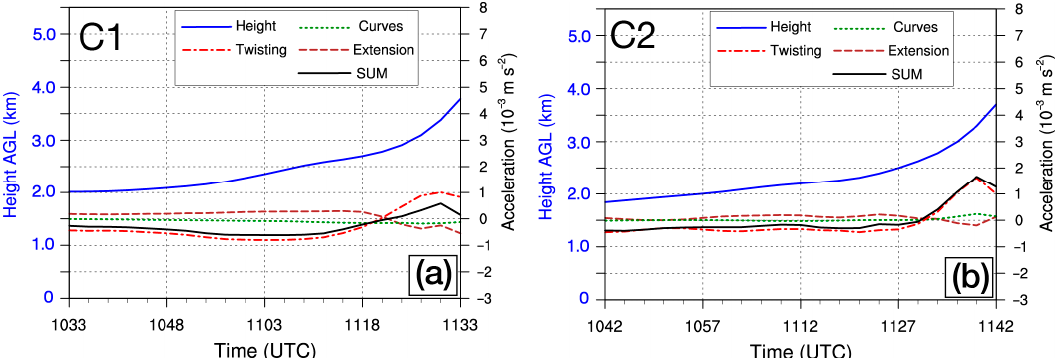
Figure 11. ( a ) Average height and three components (Curves, Twisting and Extension) of the dynamic acceleration ( a d ) and sum of them (SUM) along all air parcels selected within the C1. ( b ) is the same as ( a ) but for the C2.